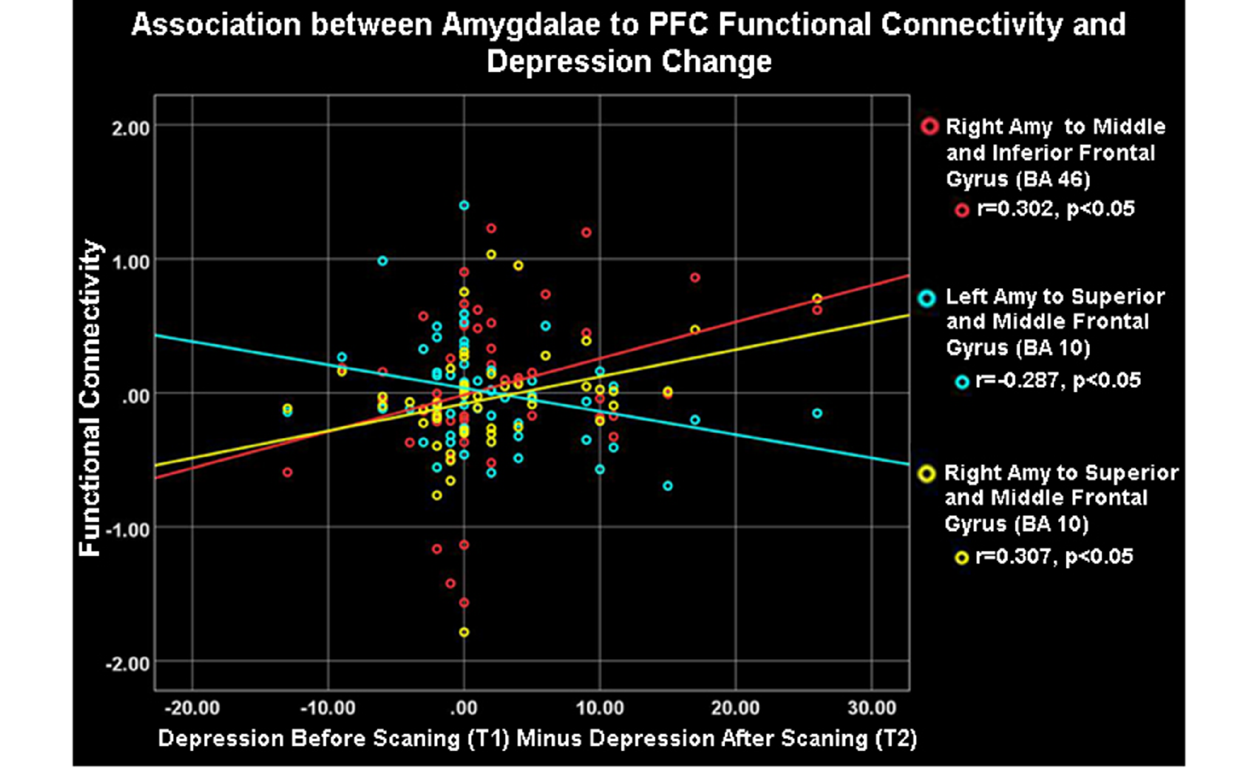
FIGURE 4 | Amygdalae to right frontocortical areas connectivity and depression change. Depression change was positively correlated with right amygdala- ipsilateral PFC connectivity (red and yellow) but negatively associated with left amygdala- right PFC connectivity (blue) during the neurofeedback procedure (ESOM-NF